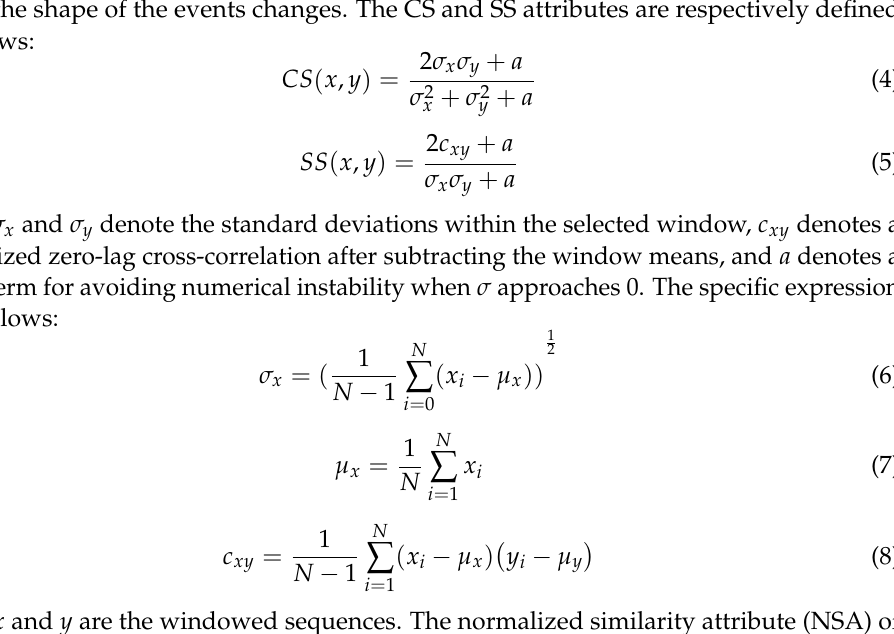
Figure 8. Time-lapse attribute value of the GPR data on 22 Jul. and 30 Jul. ( a ) SS attribute; ( b ) CS attribute; ( c ) NSA.